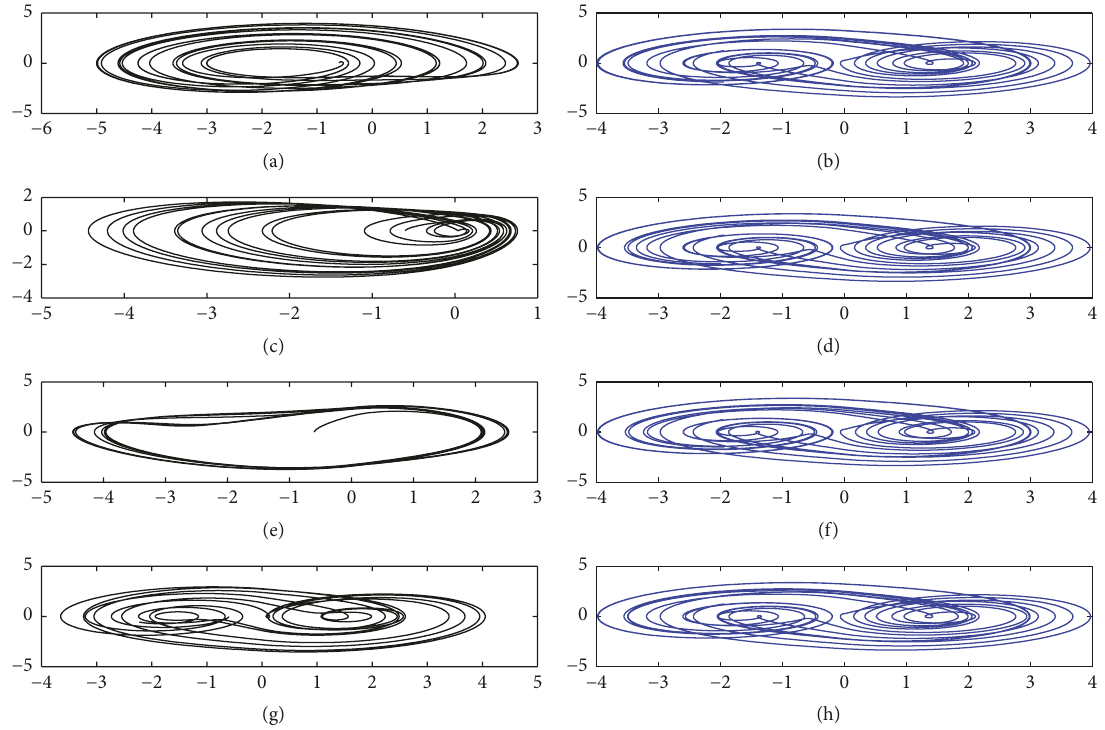
, 𝑥 ) of the phase portrait of each node of the array before (left hand) and after (right hand) applying 2 𝑖 𝑖